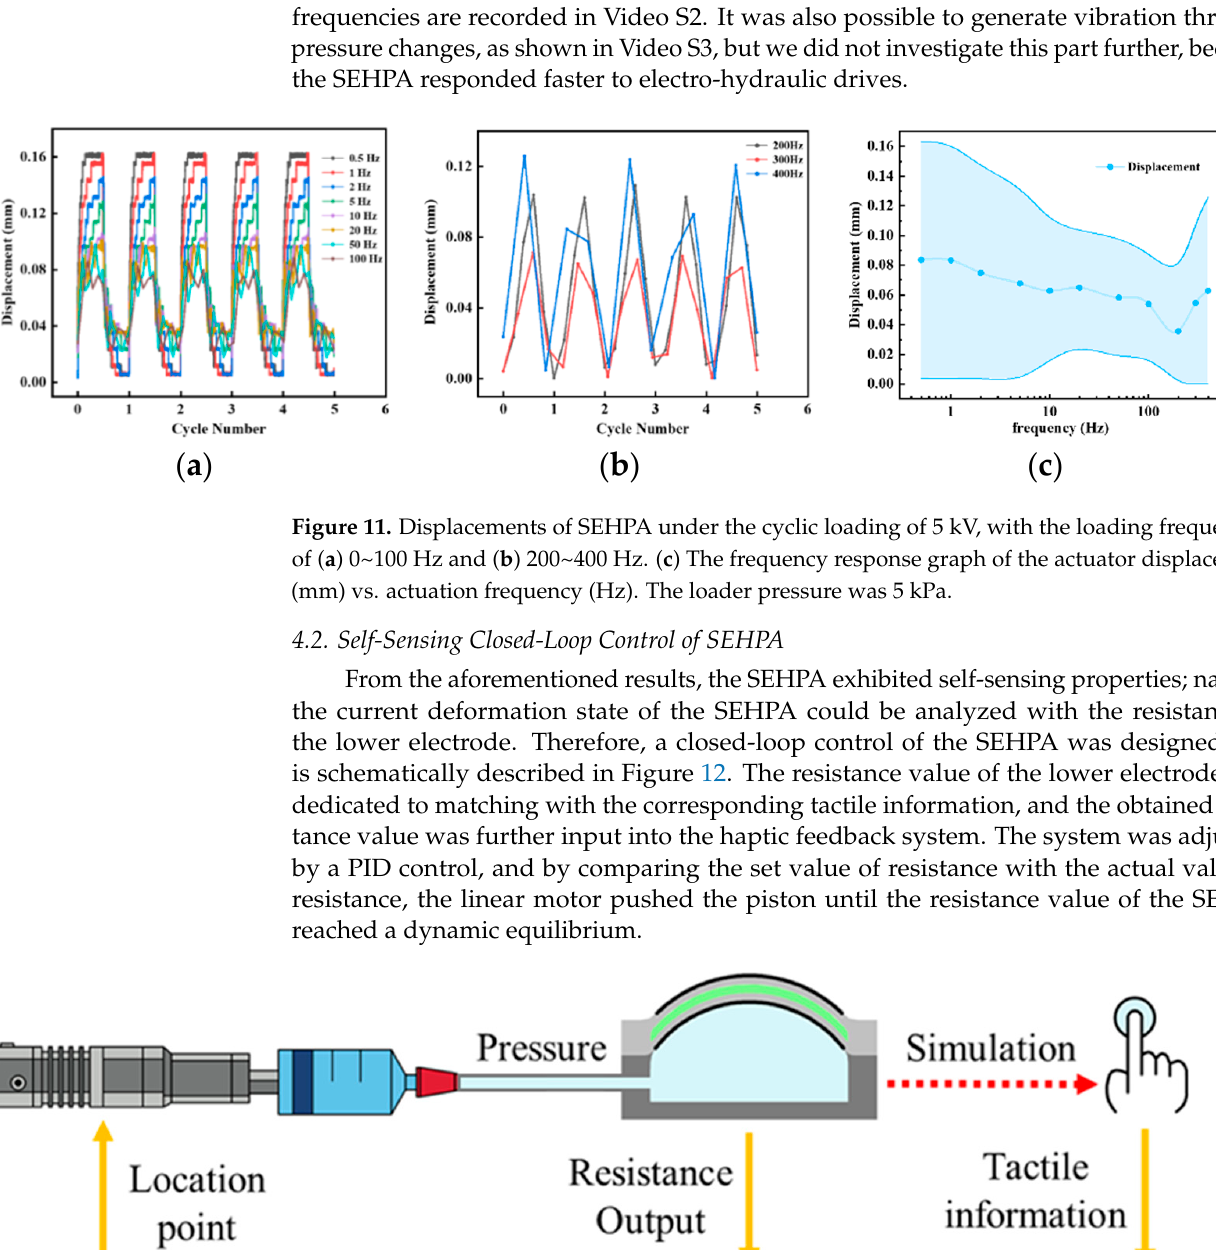
Figure 13. Relationship between lower electrode resistance versus output force of SEHPA under the closed-loop control system.